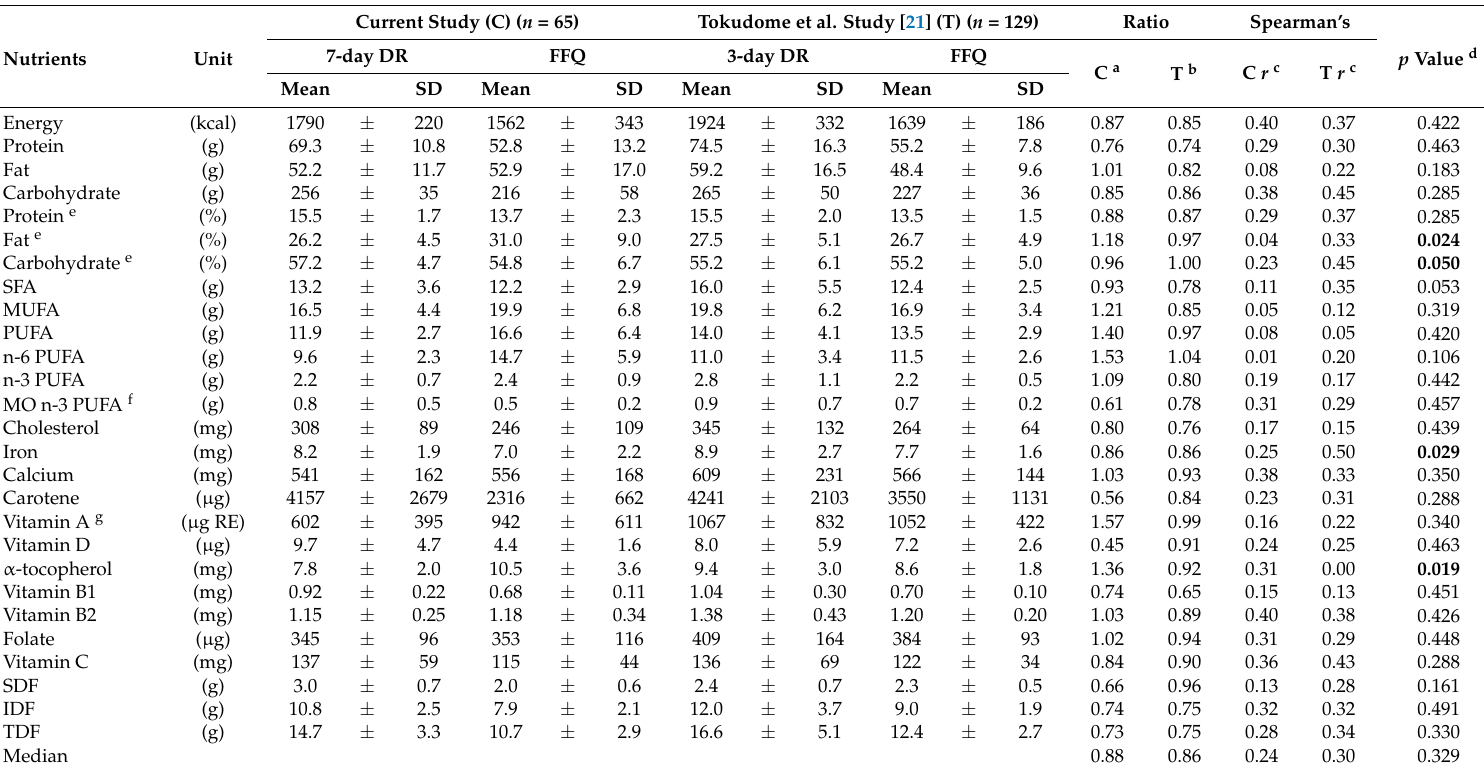
Table 2. Comparison of daily intakes of energy and nutrients measured using dietary records compared with those of a short food frequency questionnaire in